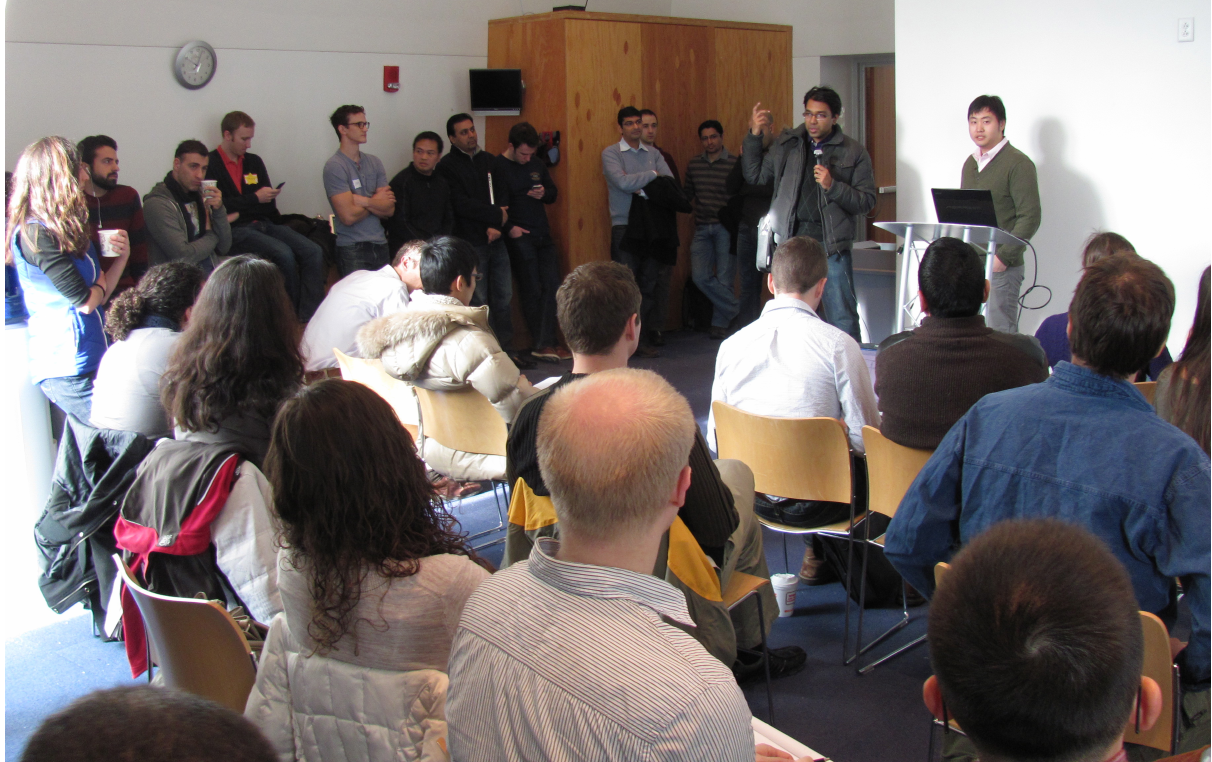
Figure 1. Presentation at the Critical Data Marathon. Photo credit: Andrew